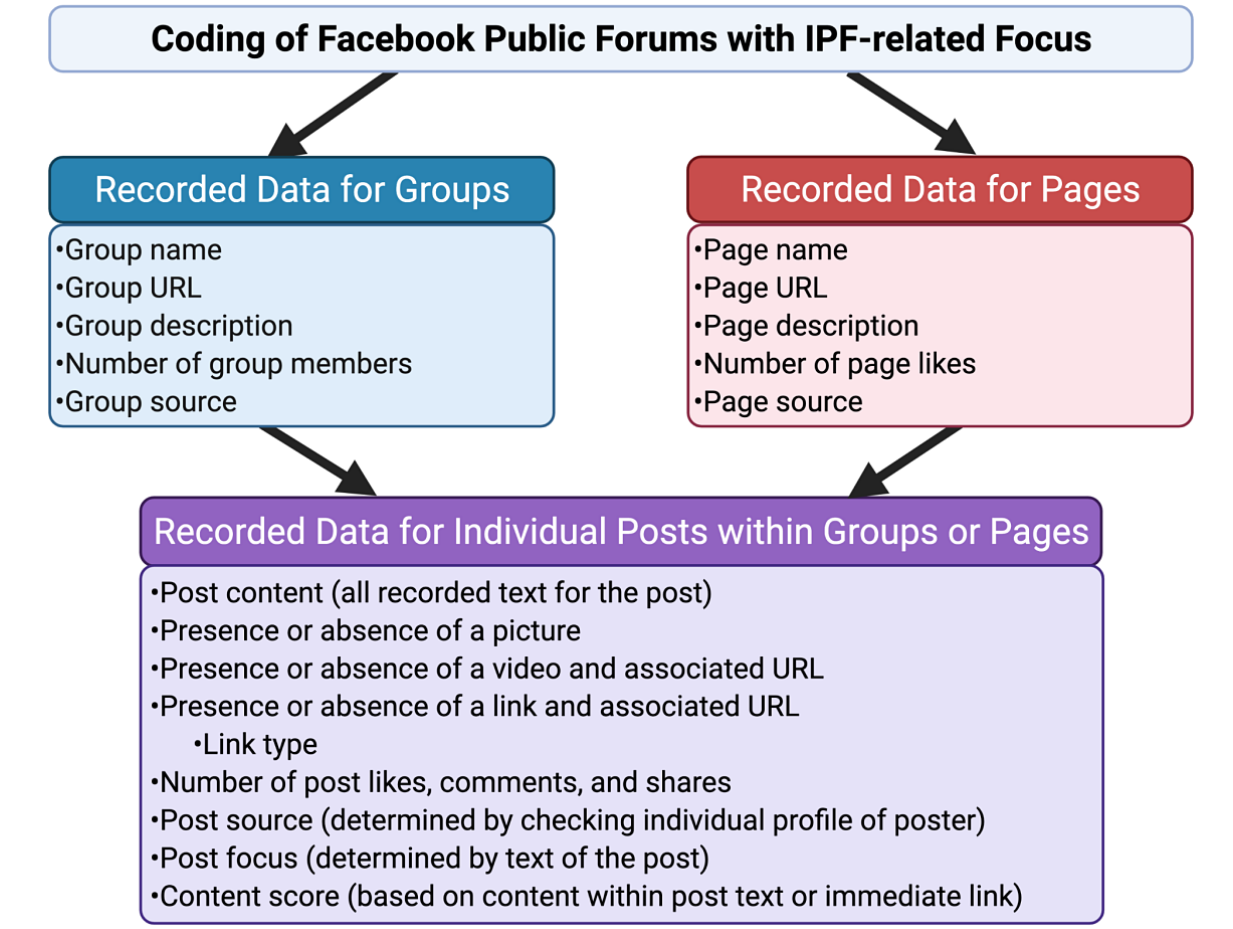
Figure 1. Data extracted from groups, pages, and from individual posts within groups or